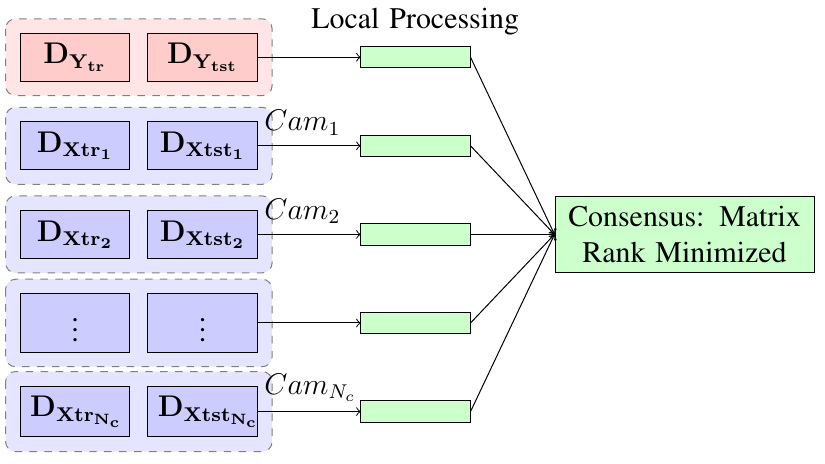
Figure 4. A model for the data split between the processing camera nodes (distributing segments of each activity between the